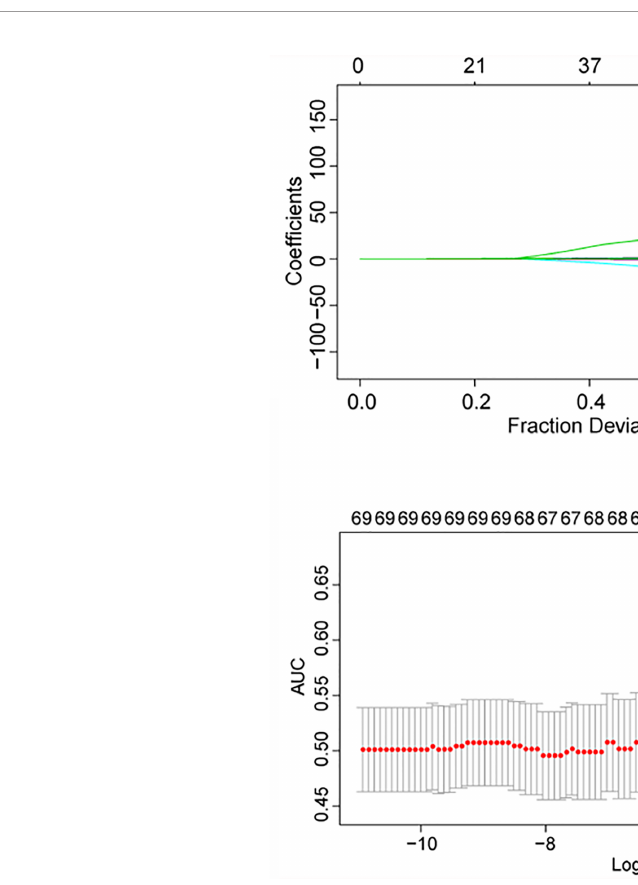
TABLE 2 | Univariate and multivariate logistic regression analysis for the fi nal model. Characteristics Univariate analysis